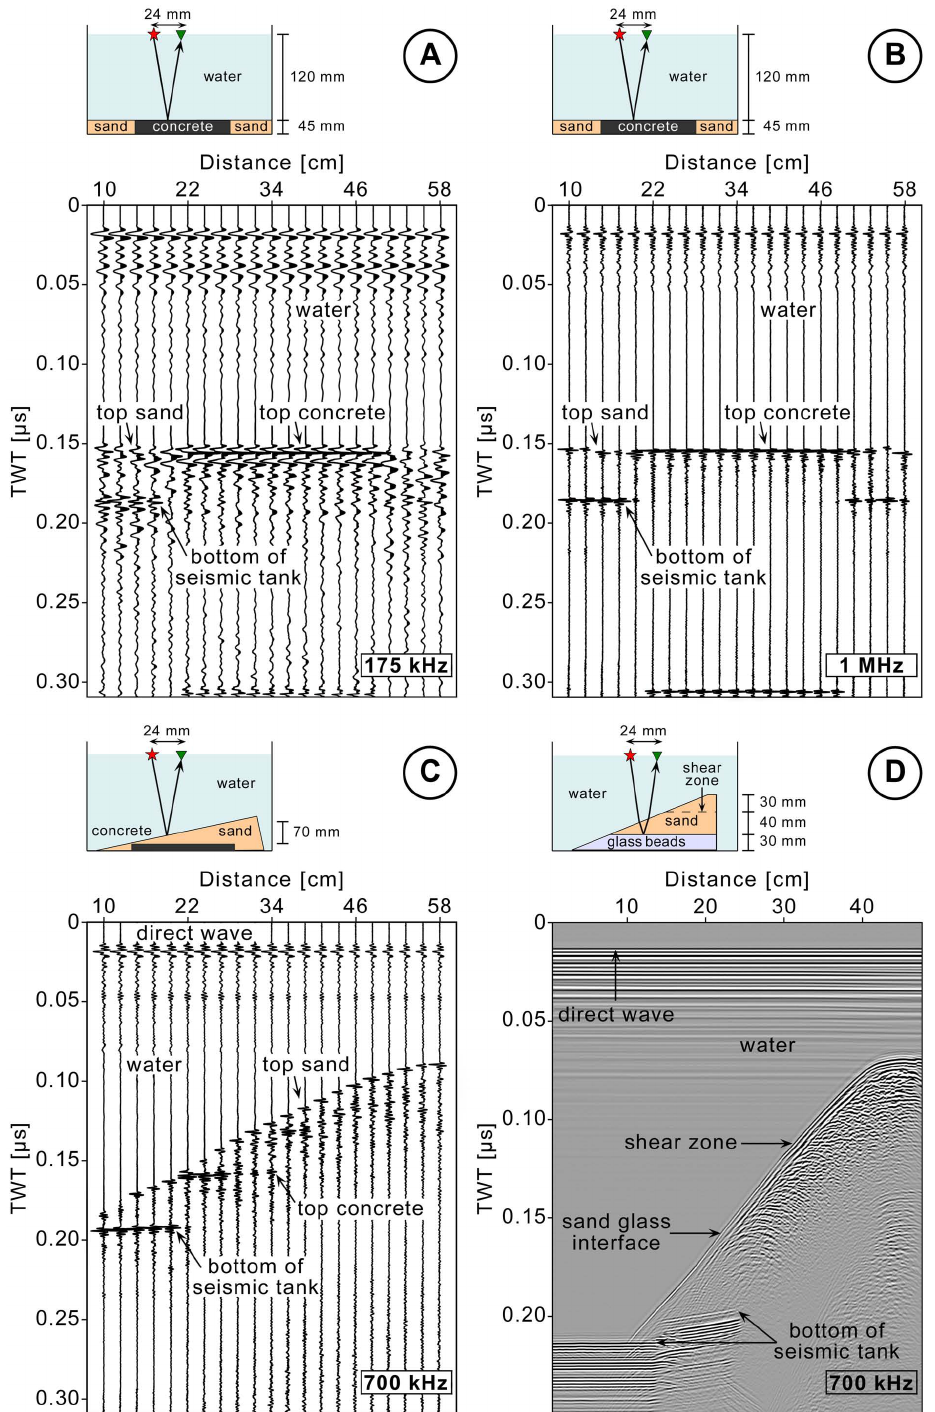
Fig. 4. Principle experiment geometries and resulting common-offset gathers from different test series acquired with the laboratory seismic system. (A, B) Flat reflector experiments testing different source frequencies; (C, D) wedge experiments with different layer materials for attenuation and scattering analyses (note the larger vertical scale in (D)